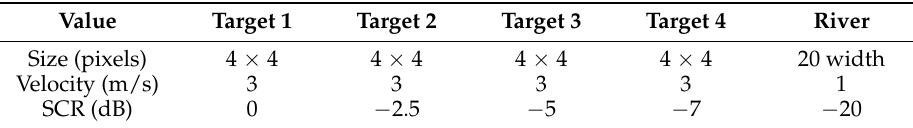
Table 2. Targets and river